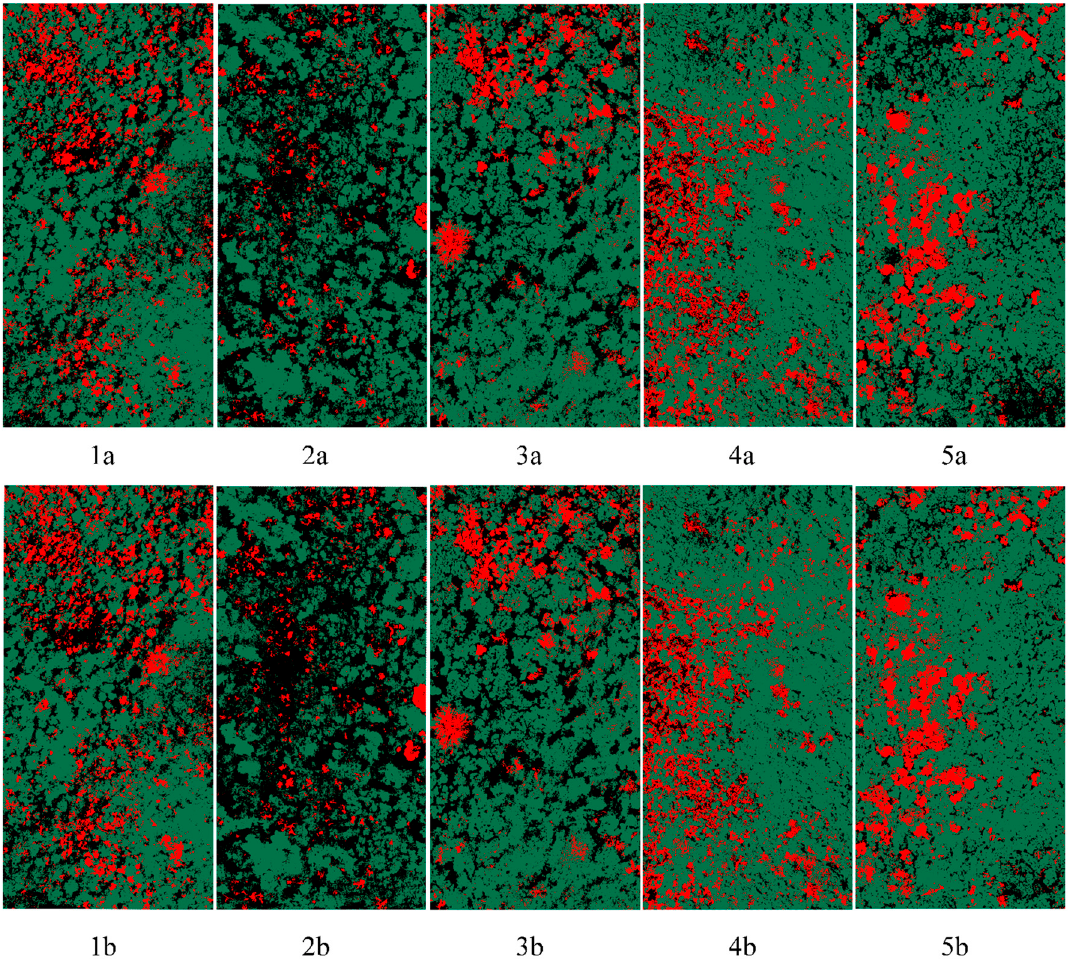
Figure 6. Classification results of the extent of the dead woody components in the five plots, marked in red and using the random forest algorithm results as an example. Plots: lot #1a-b, plot #2a-b, plot #3a-b, plot #4a-b, plot #5a-b. Top row: specific model. Bottom row: general model.